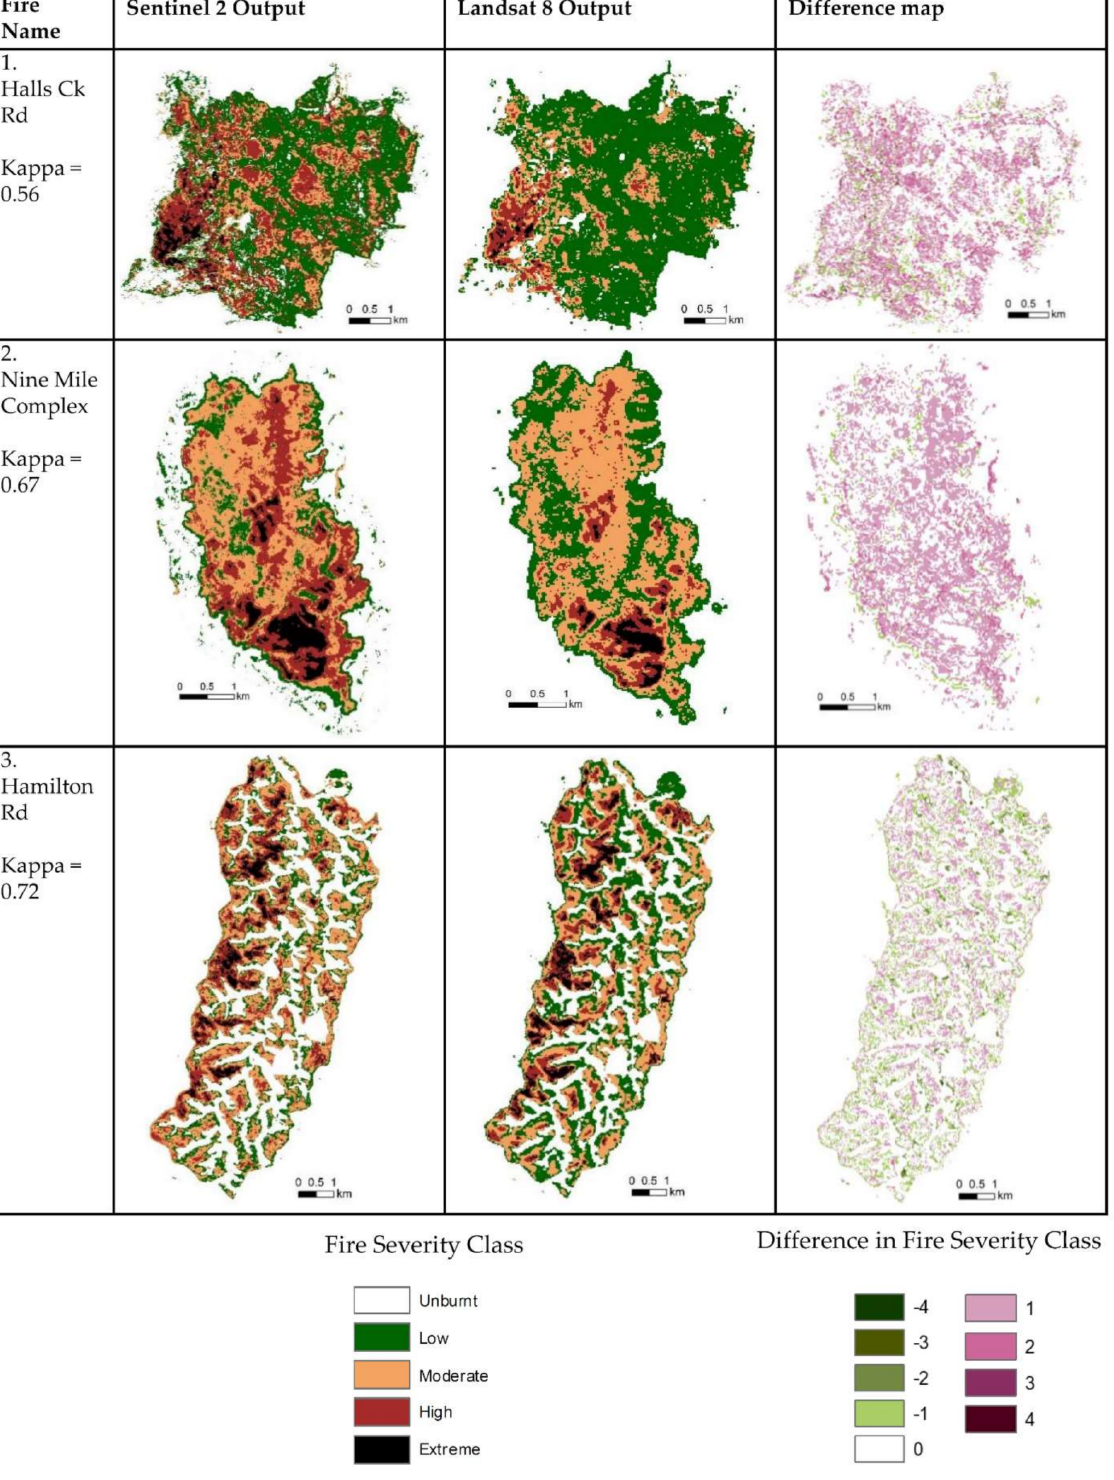
Figure 3. FESM outputs for three study fires mapped with both Sentinel 2 and Landsat 8 imagery. Difference maps show the number of classes higher or lower predicted by Sentinel 2 compared with Landsat 8. See Figure 1 to cross-reference locations of these fires in